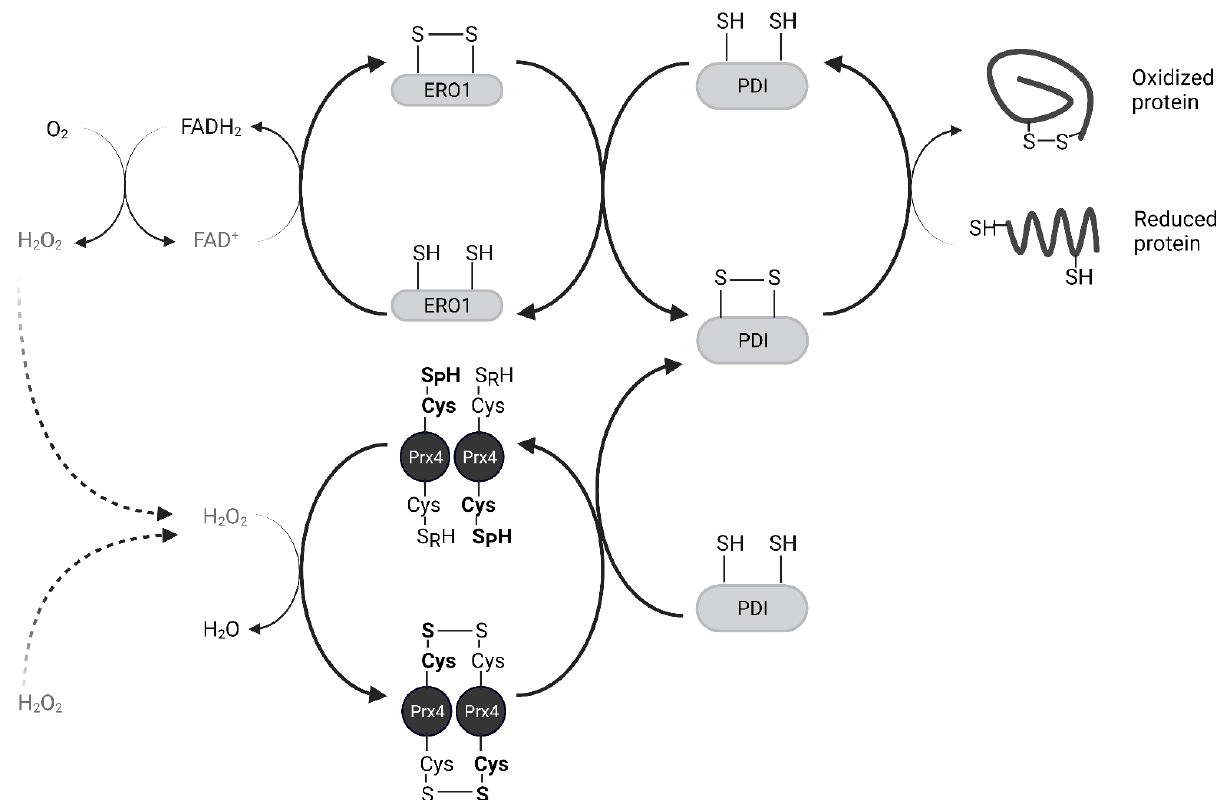
Figure 4. Prx4 mediates nascent peptide folding in the endoplasmic reticulum. Prx4 neutralizes H 2 O 2 including those produced by Ero1. Oxidized Prx4 transfers disulfides to protein disulfide iso-